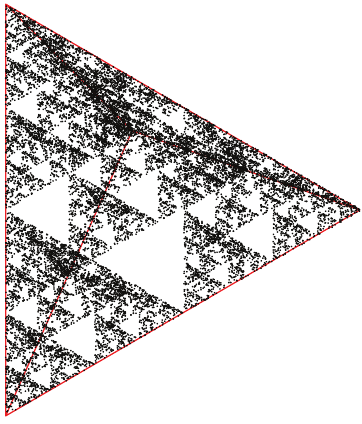
Figure 3: A representation of 𝐾 4 , generated with